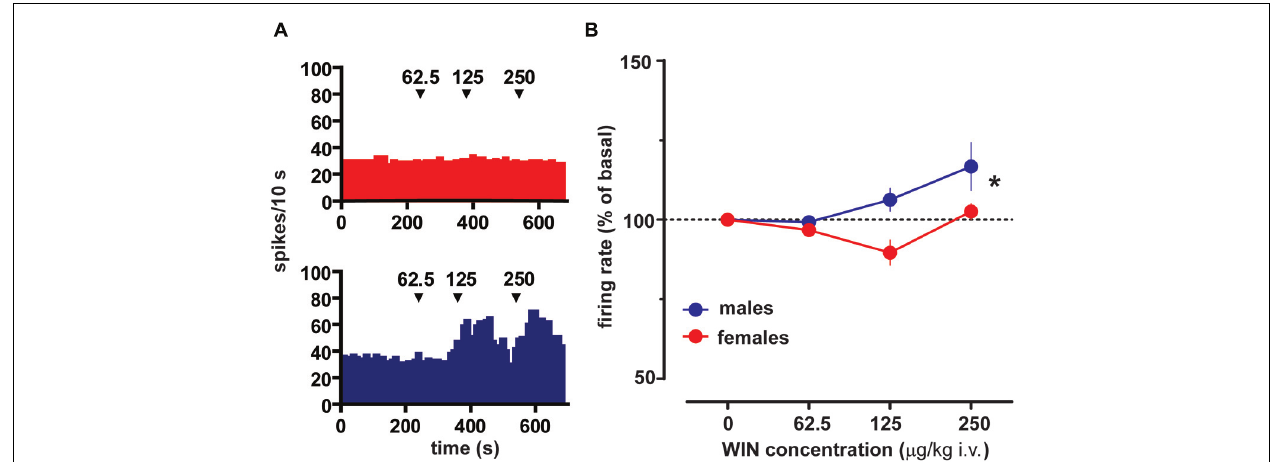
FIGURE 2 | Sex specific effect of the cannabinoid receptor agonist WIN55212-2 on VTA DA neuron firing rate. (A) Effect produced by cumulative doses of WIN on a VTA DA neuron recorded from a female (top) and a male (bottom) LH rat. Arrows indicate the time of injection. Numbers above arrows indicate the dosages expressed in μ g/kg i.v. Note the lack of stimulating effect of WIN in a female LH